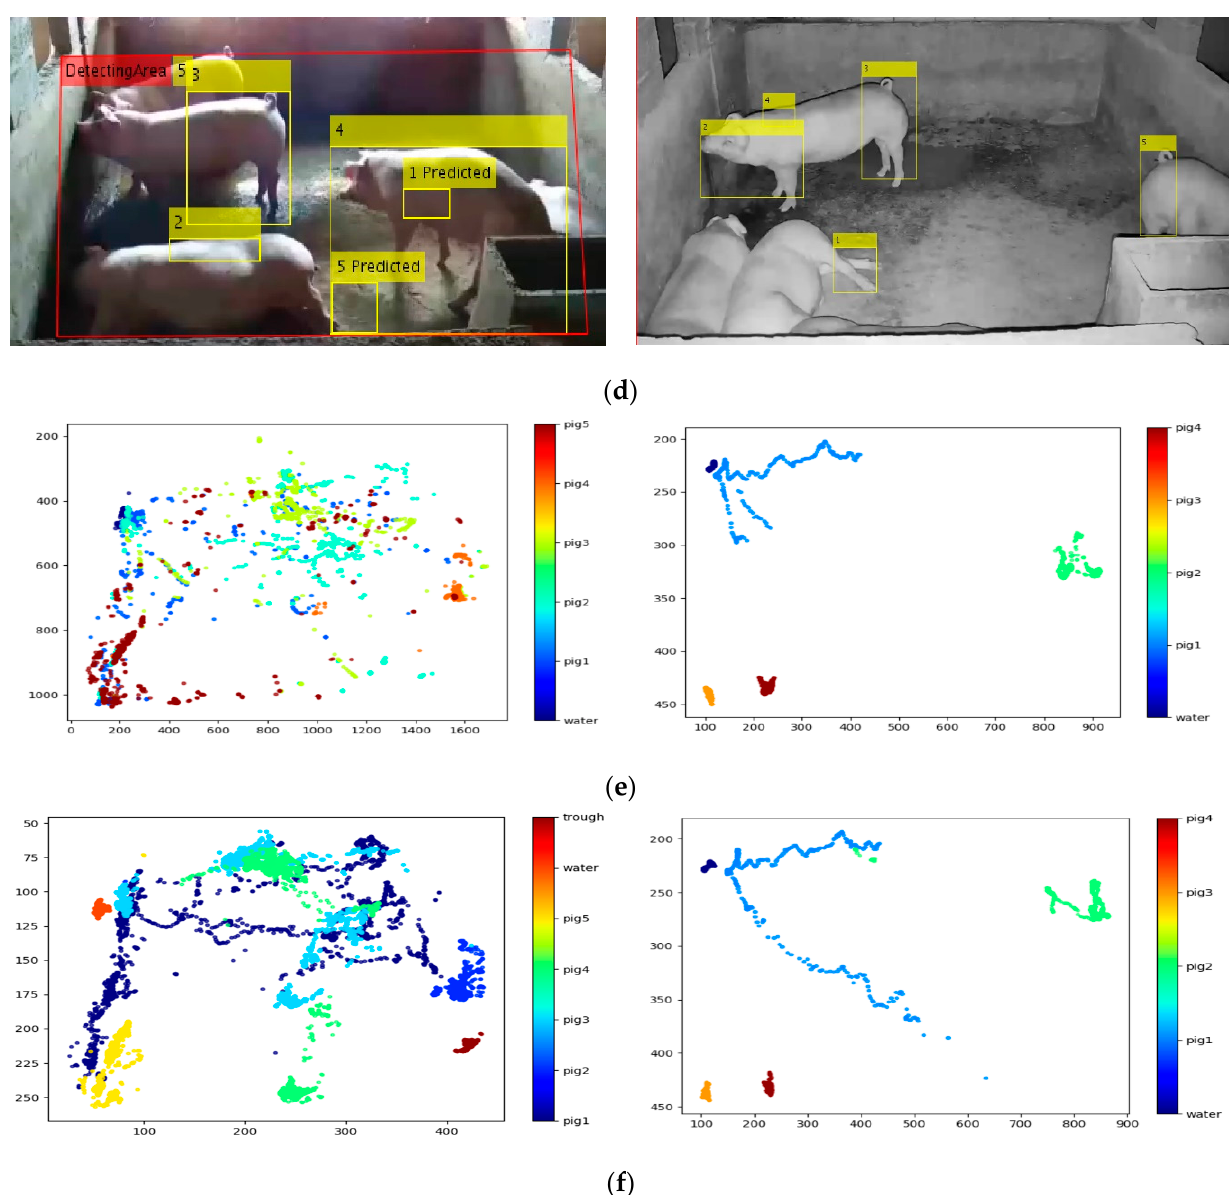
Figure 12. Trajectory collection based on different methods. ( a ) Manually fitting the trajectory route; ( b ) kalman filter; ( c ) sampling particle filter; ( d ) motion-based multi-target tracking; ( e ) traditional DeepLabCut; ( f ) improved DeepLabCut.